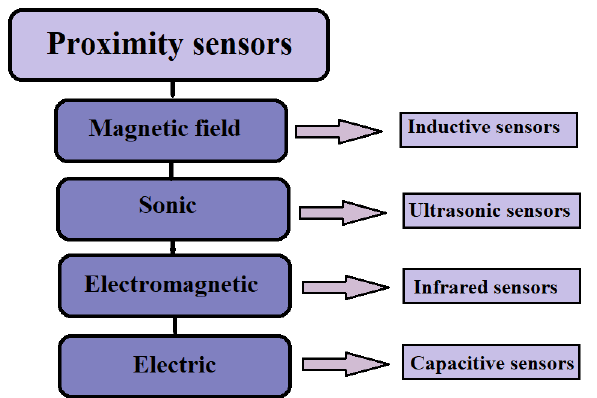
Figure 1. Different types of proximity sensors depending on the physical phenomenon utilized for sensing with representatives of each